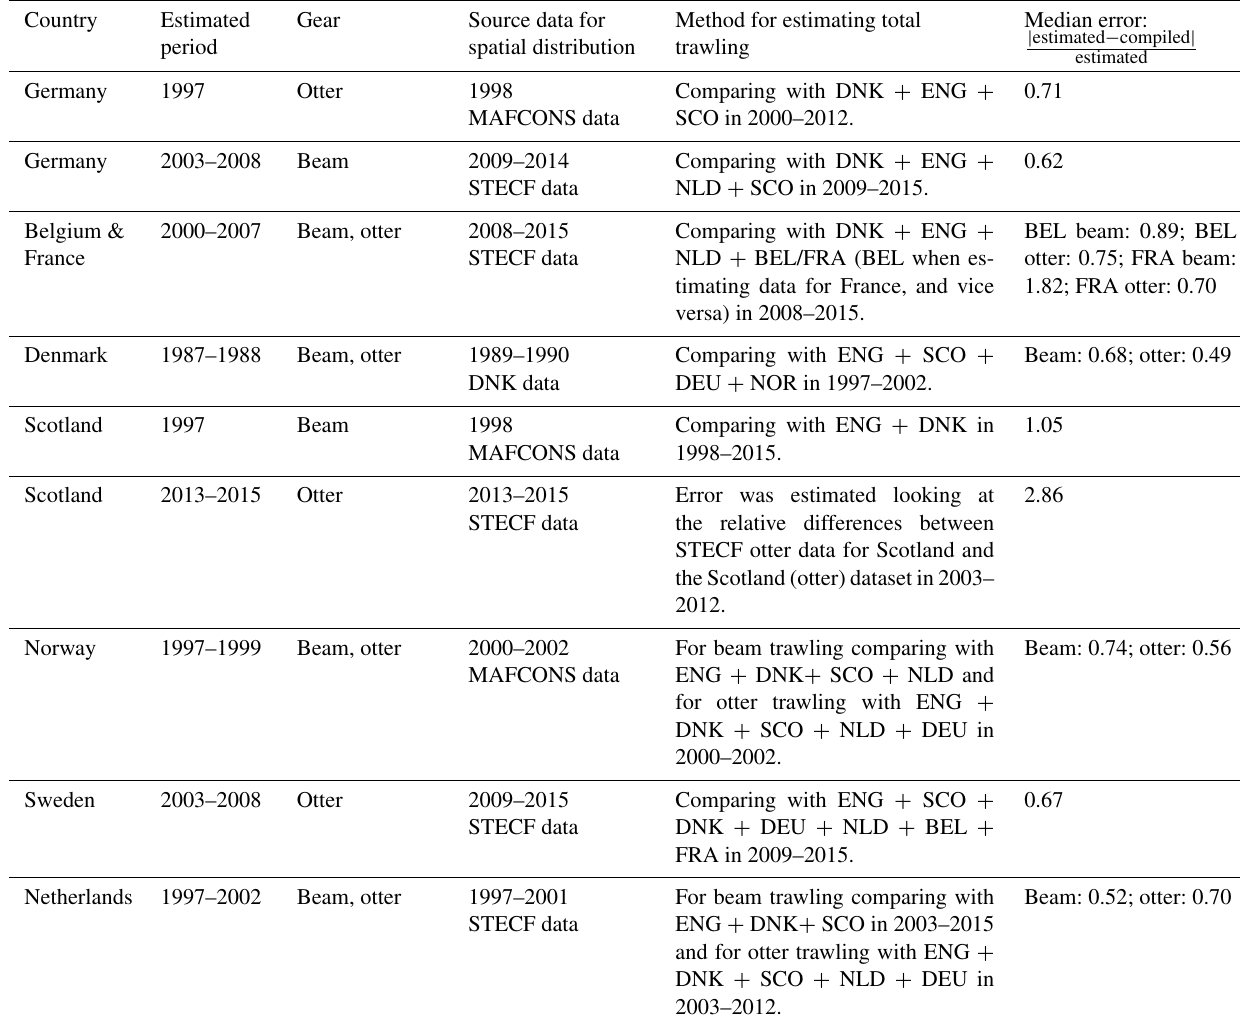
Table 2. Periods for which trawling effort was estimated for the quantification of errors for each of the countries, and the data used for each of the estimations. The last column shows the median error, where errors were calculated as of the absolute values of the relative differences between estimated and compiled data for all ICES rectangles and all